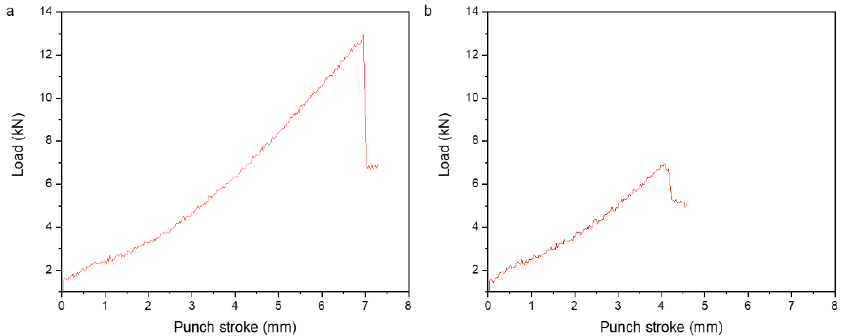
Figure 12. Load–punch stroke curves of homogenized ( a ) ZAXM2100 and ( b ) ZAXM4100 alloy sheets from Erichsen cupping test at room temperature.